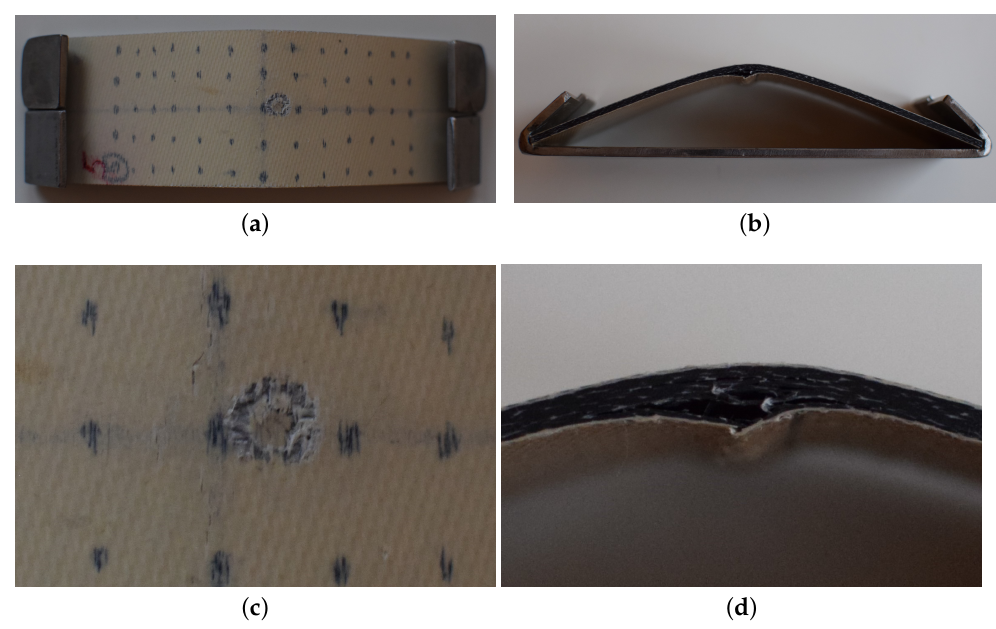
Figure 2. Curved specimen impacted after 300 thermal-shock cycles: ( a ) frontal view, ( b ) lateral view, ( c ) impact detail in the frontal view, and ( d ) impact detail in the lateral view. Table 3. Characteristics of curved specimens inspected by IRT (y: yes, n: no). Specimen Thermal Shock